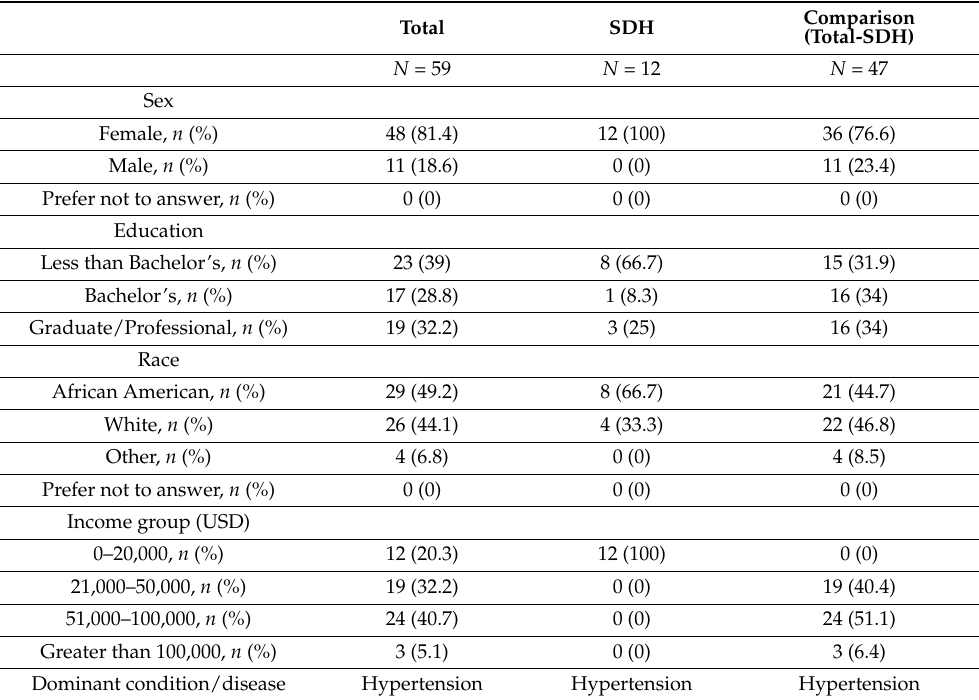
Table 1. Demographic characteristics of the whole sample ( N = 59) and the 11 participants with negative social determinants of health. Total